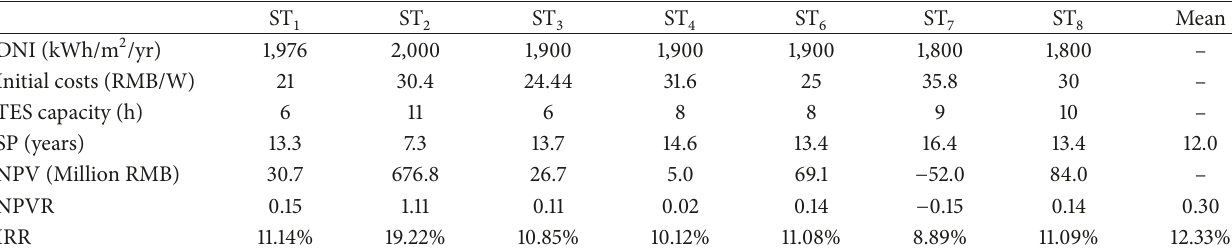
Table 3: Cost-benefit for the ST-CSP technology of China.